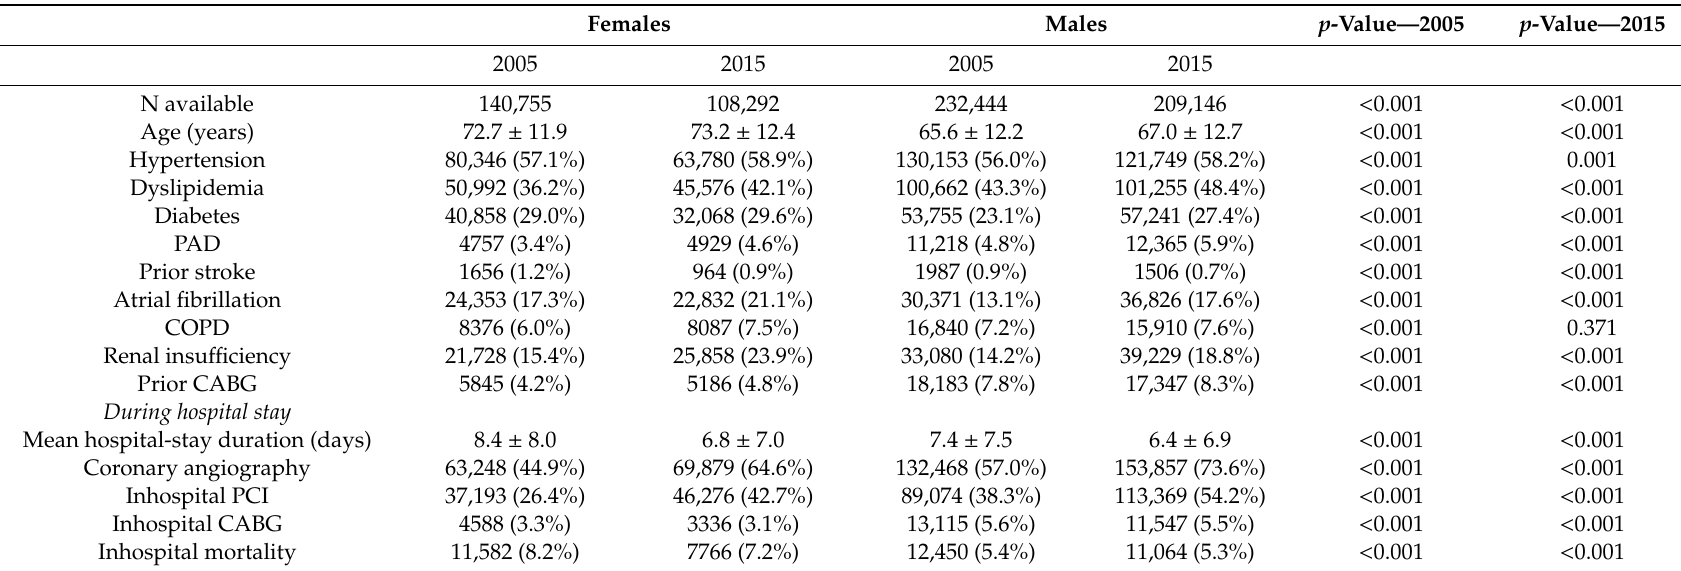
Table 2. Characteristics of female and male patients with ACS between 2005 and 2015; see Tables S3 and S4 for results displayed by year.